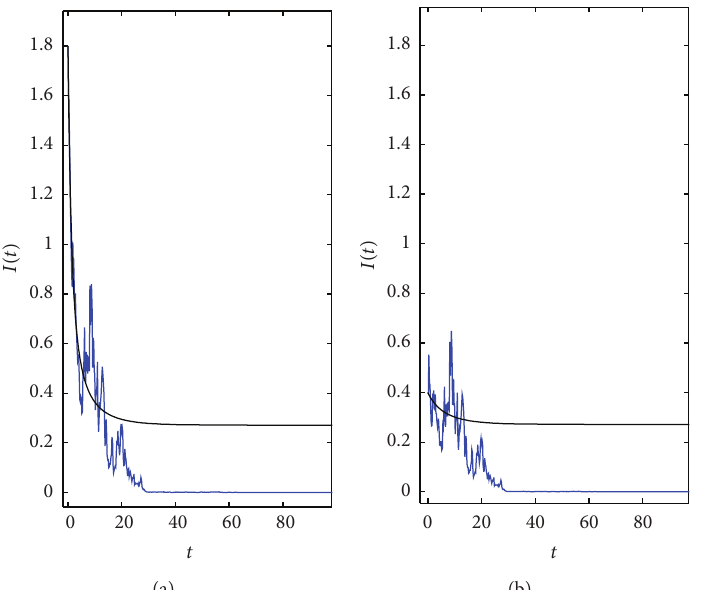
Figure 1: The solution 𝐼(𝑡) of SIS model (7) compared to the deterministic system with different initial value 𝐼(0) = 1.8 and 0.4 , 𝜎 = 0.6 . The blue line represents the solution of stochastic system, and the black line represents the solution of the corresponding deterministic system.